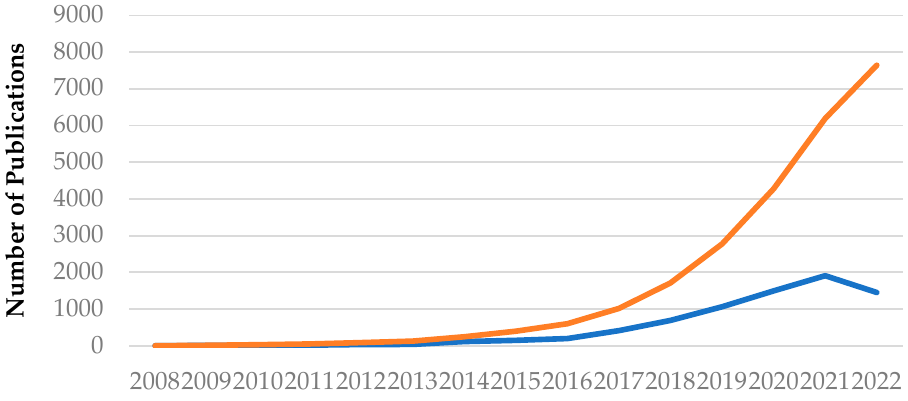
Figure 1. Evolution of scientific publications in the 2008–July 2022 period with the exact search “Soft Robotics” on the Science Direct, WOS, IEEE Xplore, and SpringerLink databases and the “ Soft Robotics” journal.